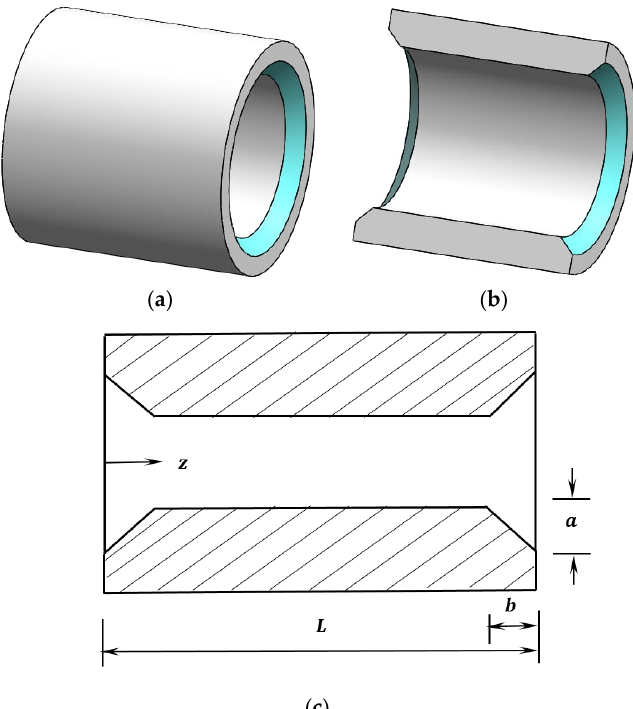
Figure 3. Bearing modification: ( a ) 3D unmodified bearing, ( b ) 3D modified bearing, and ( c ) schematic drawing of a chamfered bearing.